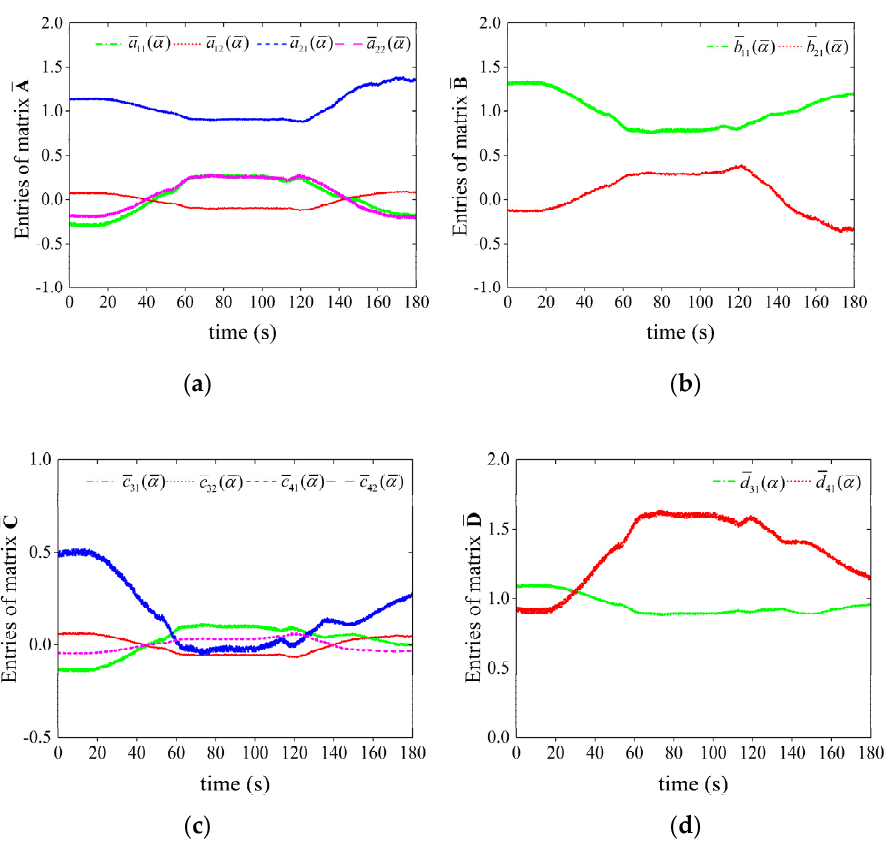
Figure 8. Parameter variations of DD-LPV model (at 3000 m, with measurement noise). ( a ) Entries of matrix A . ( b ) Entries of matrix B ( c ) Entries of matrix C . ( d ) Entries of matrix D .